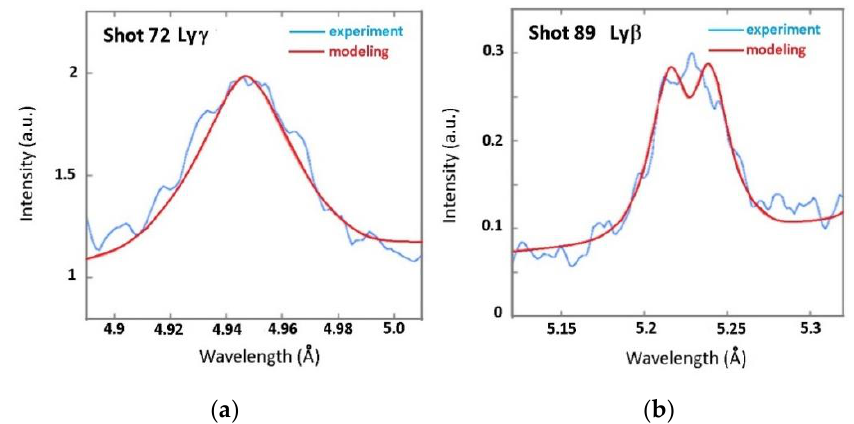
Figure 2. Experimental spectra and their comparisons with FLYCHK modeling. ( a ) Comparison of the experimental profile of Si XIV Ly γ line in shot with initial laser intensity at the surface of the target estimated as 1.01 × 10 21 W/cm 2 with a simulation performed using a variation of the code FLYCHK for calculating the Stark broadening, then adding both Doppler and instrument broadening, and if necessary, opacity. The L-dips phenomenon and the spectral line broadening by LET were not included in the FLYCHK. The plasma parameters for the best fit are N e = 0.9 × 10 23 cm − 3 and T e = 500 eV. ( b ) The same as in ( a ) but for Si XIV Ly β line produced in a single laser shot with initial laser intensity at the surface of the target estimated as 0.24 × 10 21 W/cm 2 ; N e = 3 × 10 23 cm − 3 and T e = 500 eV